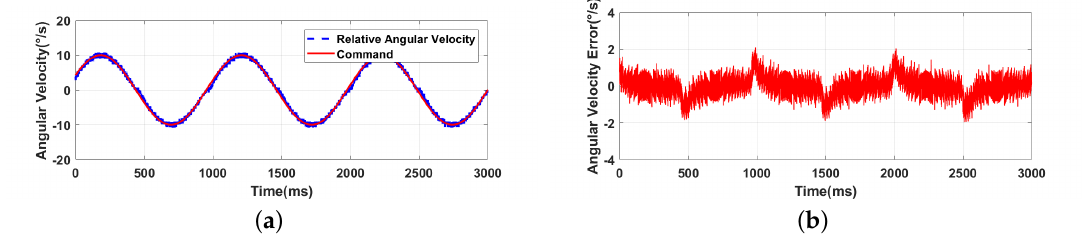
Figure 11. Group C: Modified PI controller u ∗ c with a light base support. ( a ) Sine command and relative angular velocity; ( b ) Relative angular velocity error.